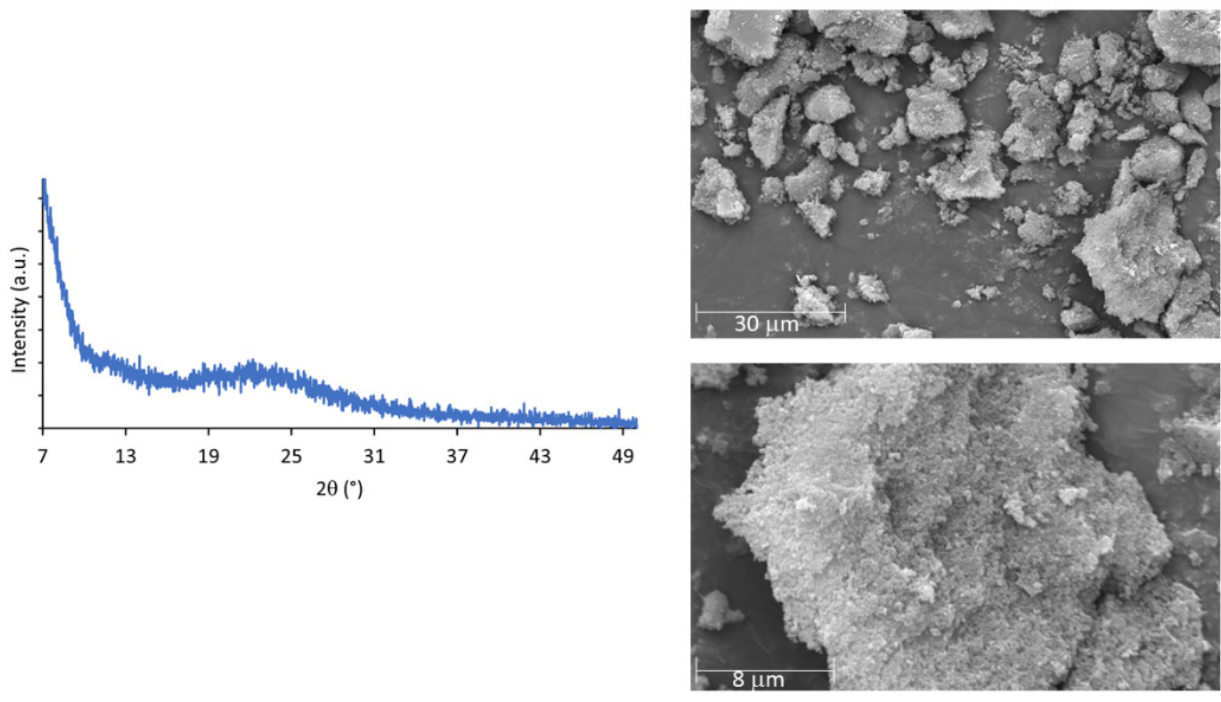
Figure 3. Powder XRD patterns ( left ) and SEM images ( right ) of the i ‐ POF. The N adsorption–desorption isotherm at − 196 °C (Figure 4—top) shows a typical 2